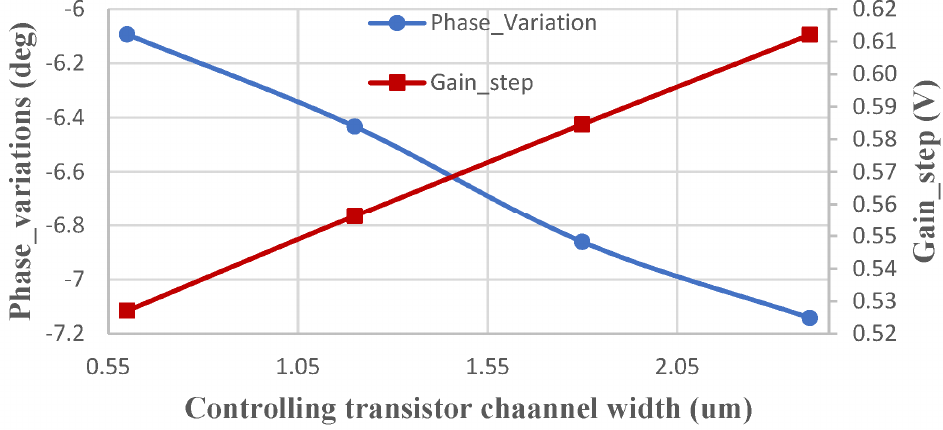
Figure 10. Phase variations and gain step versus the controlling transistor channel width.